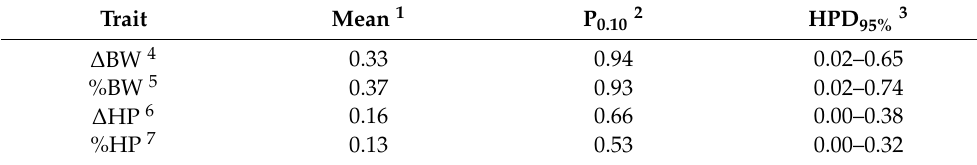
Table 5. Heritability estimates for the resilience indicators.